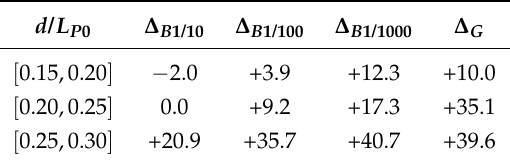
Table 6. Negative force peaks: percentage difference between Boccotti’s model and measured